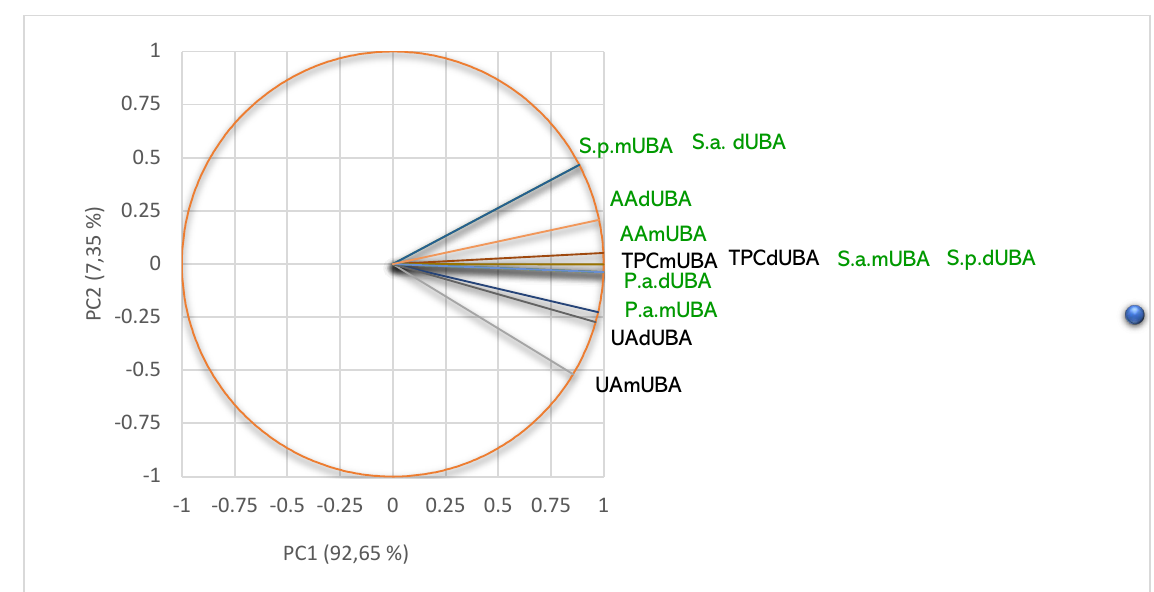
Figure 9. PCA-Correlation circle between TPC, UA, and individual polyphenols in m UBA and d UBA and antibacterial and antiradical activities; UBA— U. barbata acetone extract, m —macerate, d —dry;